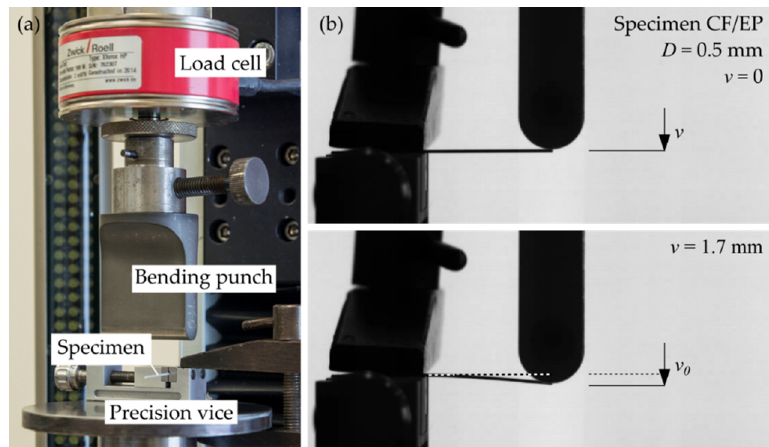
Figure 5. ( a ) Experimental setup for determination of flexural modulus and ( b ) exemplary illustration of a beams deflection as described by means of the static beam equation.